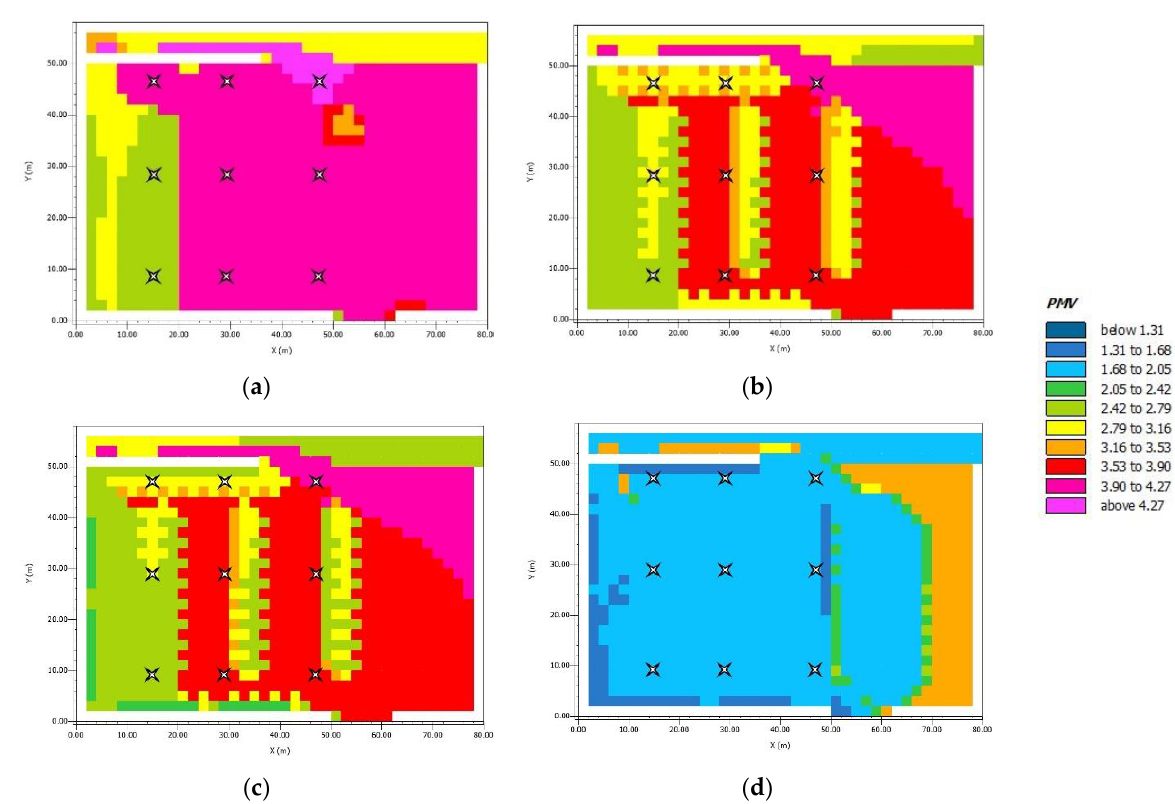
Figure 13. PMV at 04:00 p.m. in July. ( a ) AS; ( b ) LC+G1; ( c ) LC+G2; ( d )